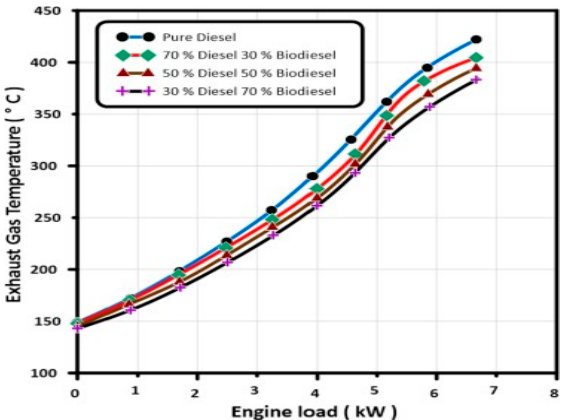
Figure 5. Variation of exhaust gas temperature (EGT) with different engine loads for different test fuels [65].